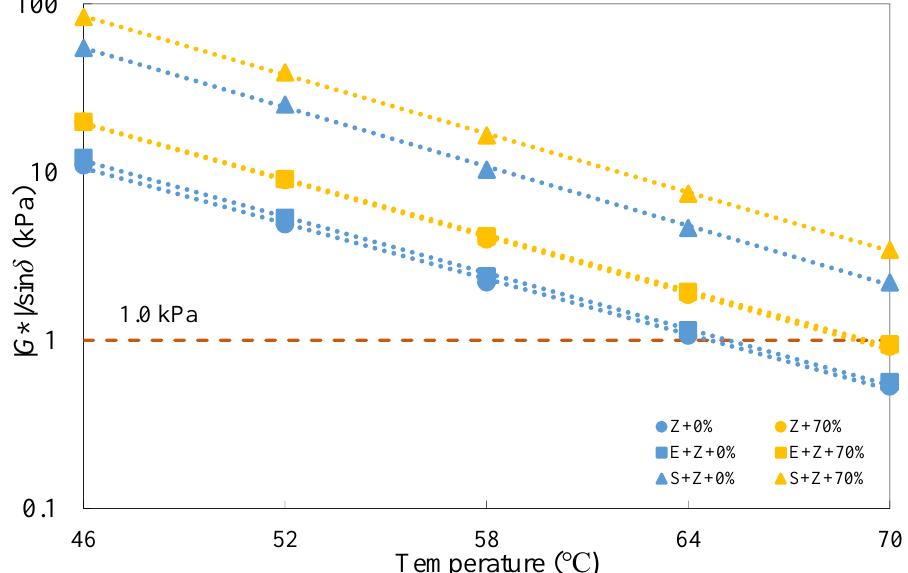
Figure 7. Rutting parameter test results of the warm-mix recycled binders at different testing tem- peratures under the unaged condition.